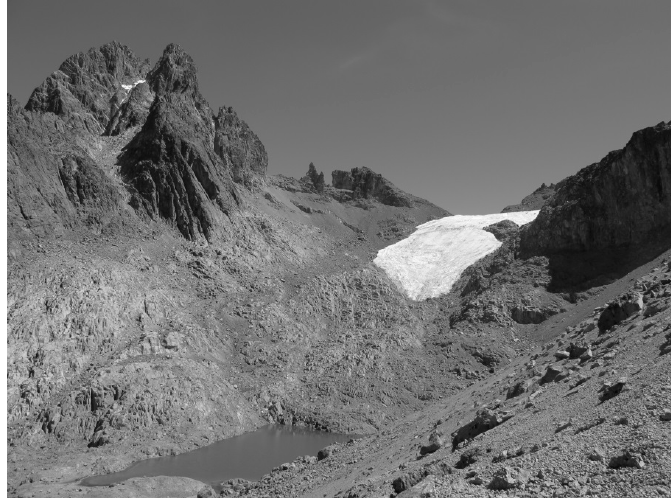
Figure 1. Lewis Glacier above Lewis Tarn seen from its late 19th century lateral moraine on 01 March 2011. Note the steep walls of the two highest peaks of the massif, Batian (5199 m) and Nelion (5188 m), which rise to the upper left corner. Photo credit R. Prinz.